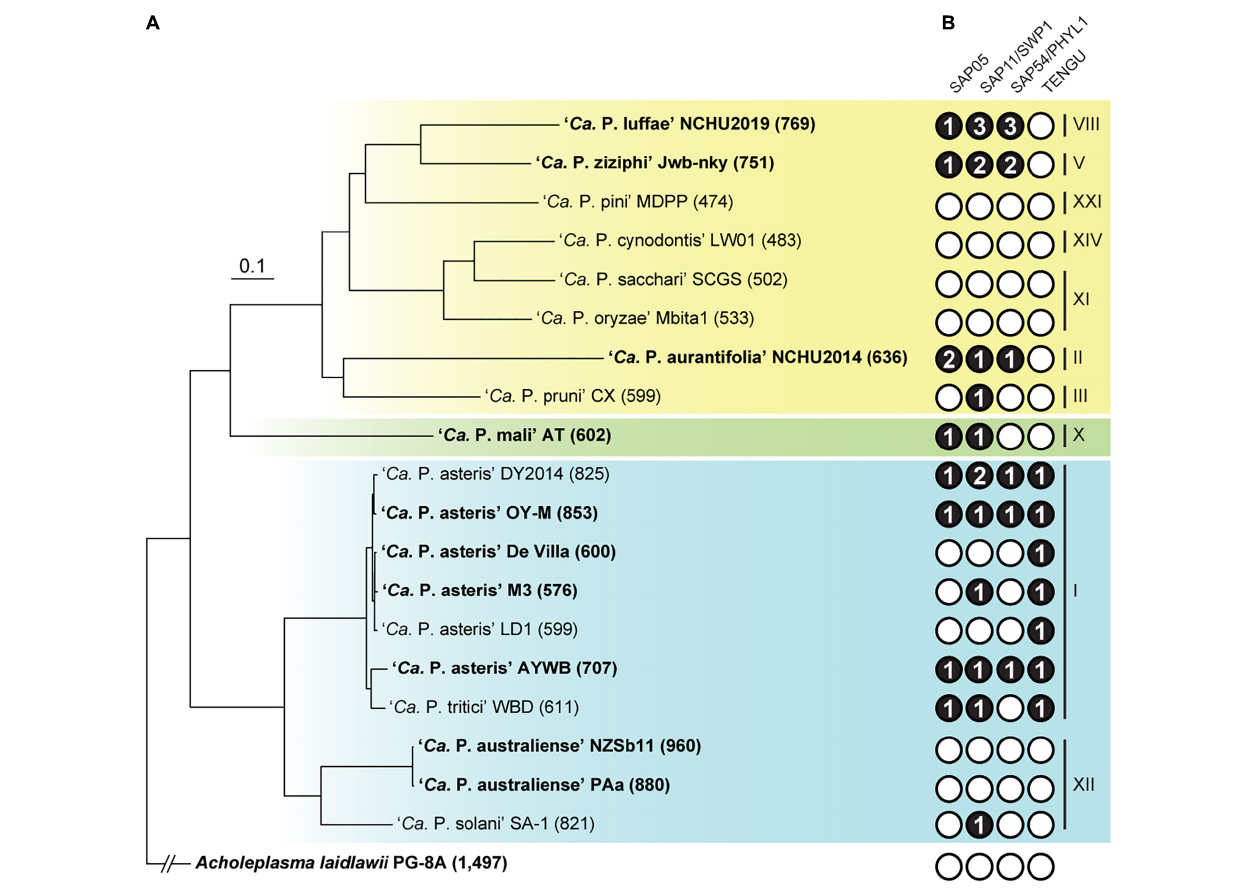
FIGURE 3 | Evolutionary relationships among representative phytoplasmas with genome sequences available. The 16S rRNA gene (16Sr) group assignments are labeled on the right. The three major phylogenetic clusters are indicated by colored backgrounds (I: blue; II; green; III: yellow). Acholeplasma laidlawii is included as the outgroup. (A) Maximum likelihood phylogeny inferred based on a concatenated alignment of 80 conserved single-copy genes (27,742 aligned amino acid sites). All internal nodes received > 80% bootstrap support based on 1,000 re-sampling. Strains with complete genome assemblies available are highlighted in bold. The number in parentheses following the strain name indicates the genome size (in kb). (B) Distribution of known effector genes. Gene presence and absence are indicated by filled (with copy numbers) and empty circles,